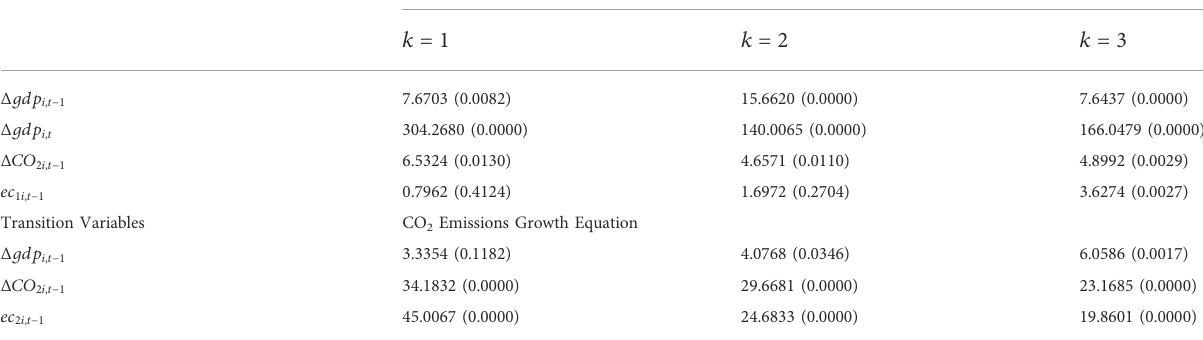
TABLE 4 Linearity test results.